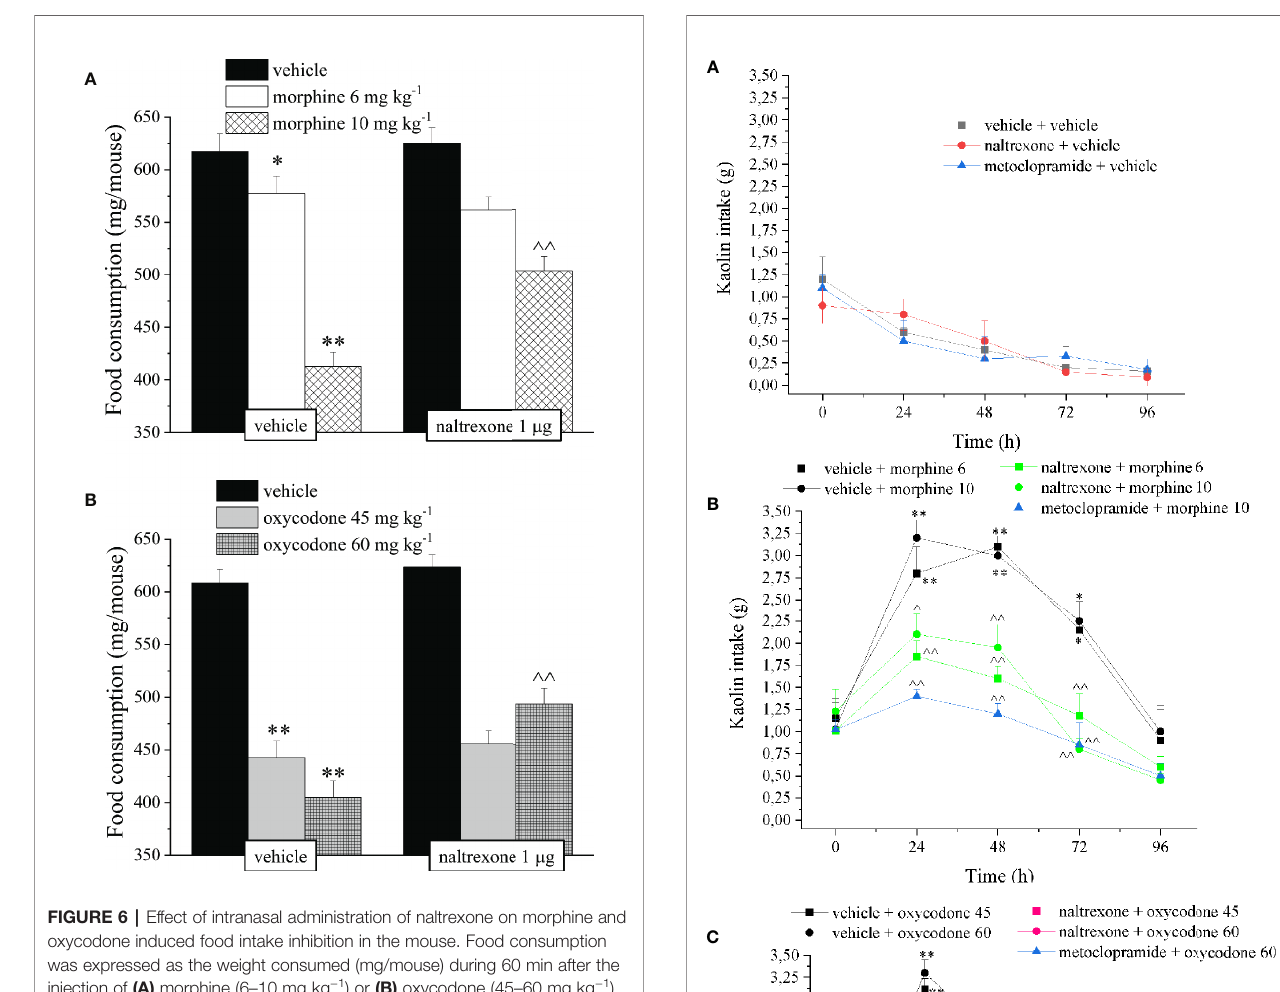
Control animals were treated with vehicles. Each value represents the mean of 10 rats per group, performed in two different experimental sets. *P < 0.05 and **P < 0.01 vs vehicle-treated animals; ^P < 0.05 and ^^P < 0.01 vs morphine or oxycodone-treated